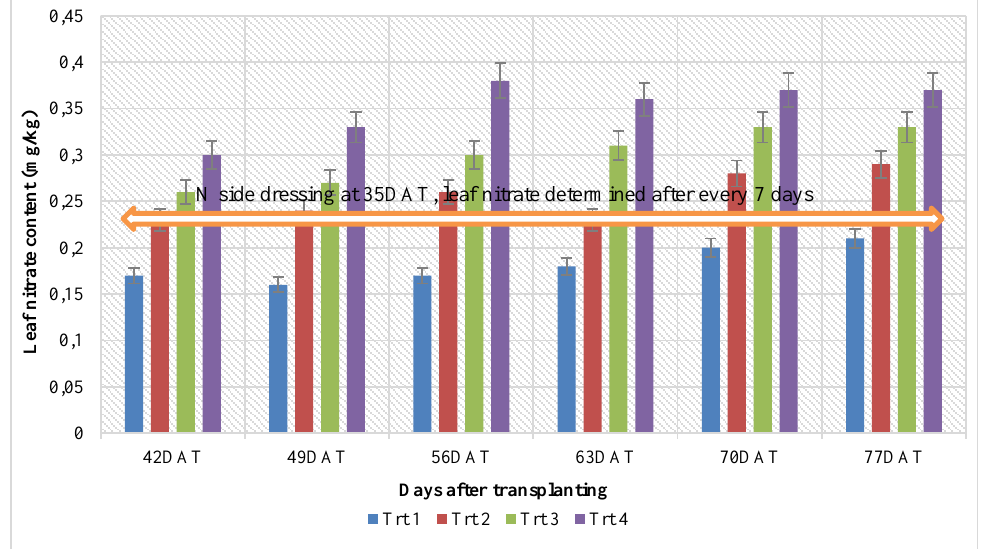
Figure 4a . Leaf nitrate content responses over the leaf harvesting period after N fertilizer application